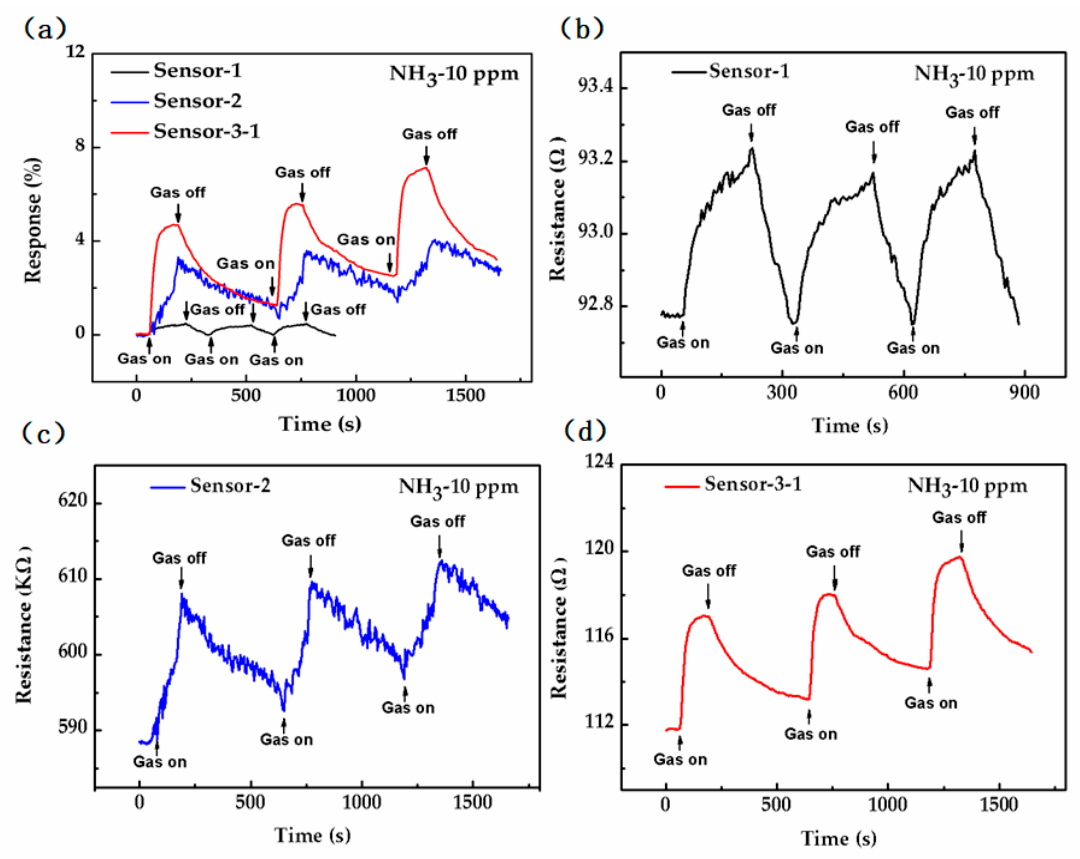
Figure 6. ( a ) Response of three types of sensors to 10 ppm ammonia; Resistance changes of ( b ) Sensor-1; ( c ) Sensor-2; and ( d ) Sensor-3-1 to 10 ppm ammonia gas respectively. R ammonia and R air are the electrical resistance values with and without ammonia gas, respectively.